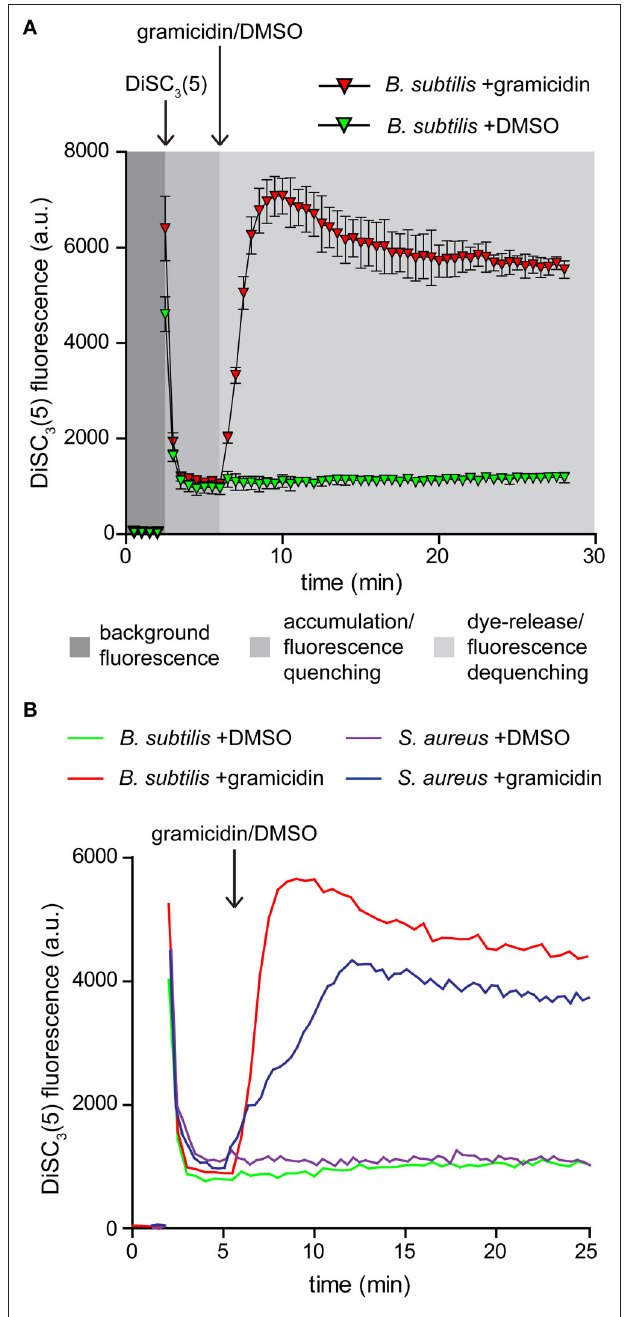
FIGURE 2 | Membrane potential sensitive fluorescent dye DiSC 3 (5). (A) Fluorescence intensity changes of DiSC 3 (5) in a cell suspension. The time points of dye and gramicidin addition are highlighted with arrows. Note the strong quenching of DiSC 3 (5) fluorescence upon accumulation in cells, and the dequenching upon membrane depolarization. The solvent used to solubilize gramicidin (DMSO) has no influence on the fluorescence intensity levels. The graph depicts average and standard deviation of three technical replicates. (B) A comparison of fluorescence intensity changes of DiSC 3 (5) upon accumulation in polarized B. subtilis and S. aureus cells, and upon depolarization with gramicidin (1 µ M). The time point of gramicidin addition is highlighted with an arrow. Strains used: B. subtilis 168 (wild type) and S. aureus RN4220 (wild